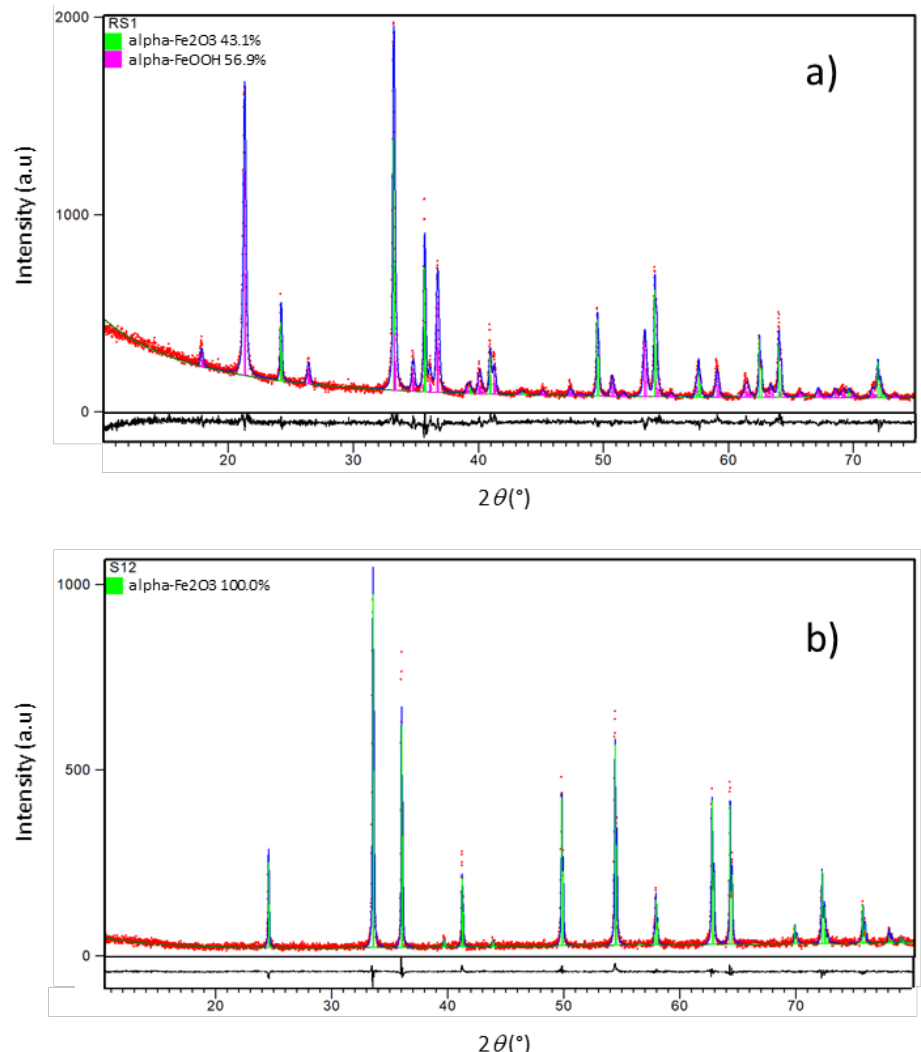
Figure 3. Final observed (red dots) and calculated (blue solid line) powder diffraction profile for ( a ) sample RS1 and ( b ) sample S12 as obtained from Rietveld refinements against PXRD data at RT. The fitted background contribution is represented by the lower dark green solid line. The black solid line (bottom) shows the difference profile, while the green and purple vertical lines show the reflection positions of hexagonal α -Fe 2 O 3 and orthorhombic α -FeOOH, respectively.